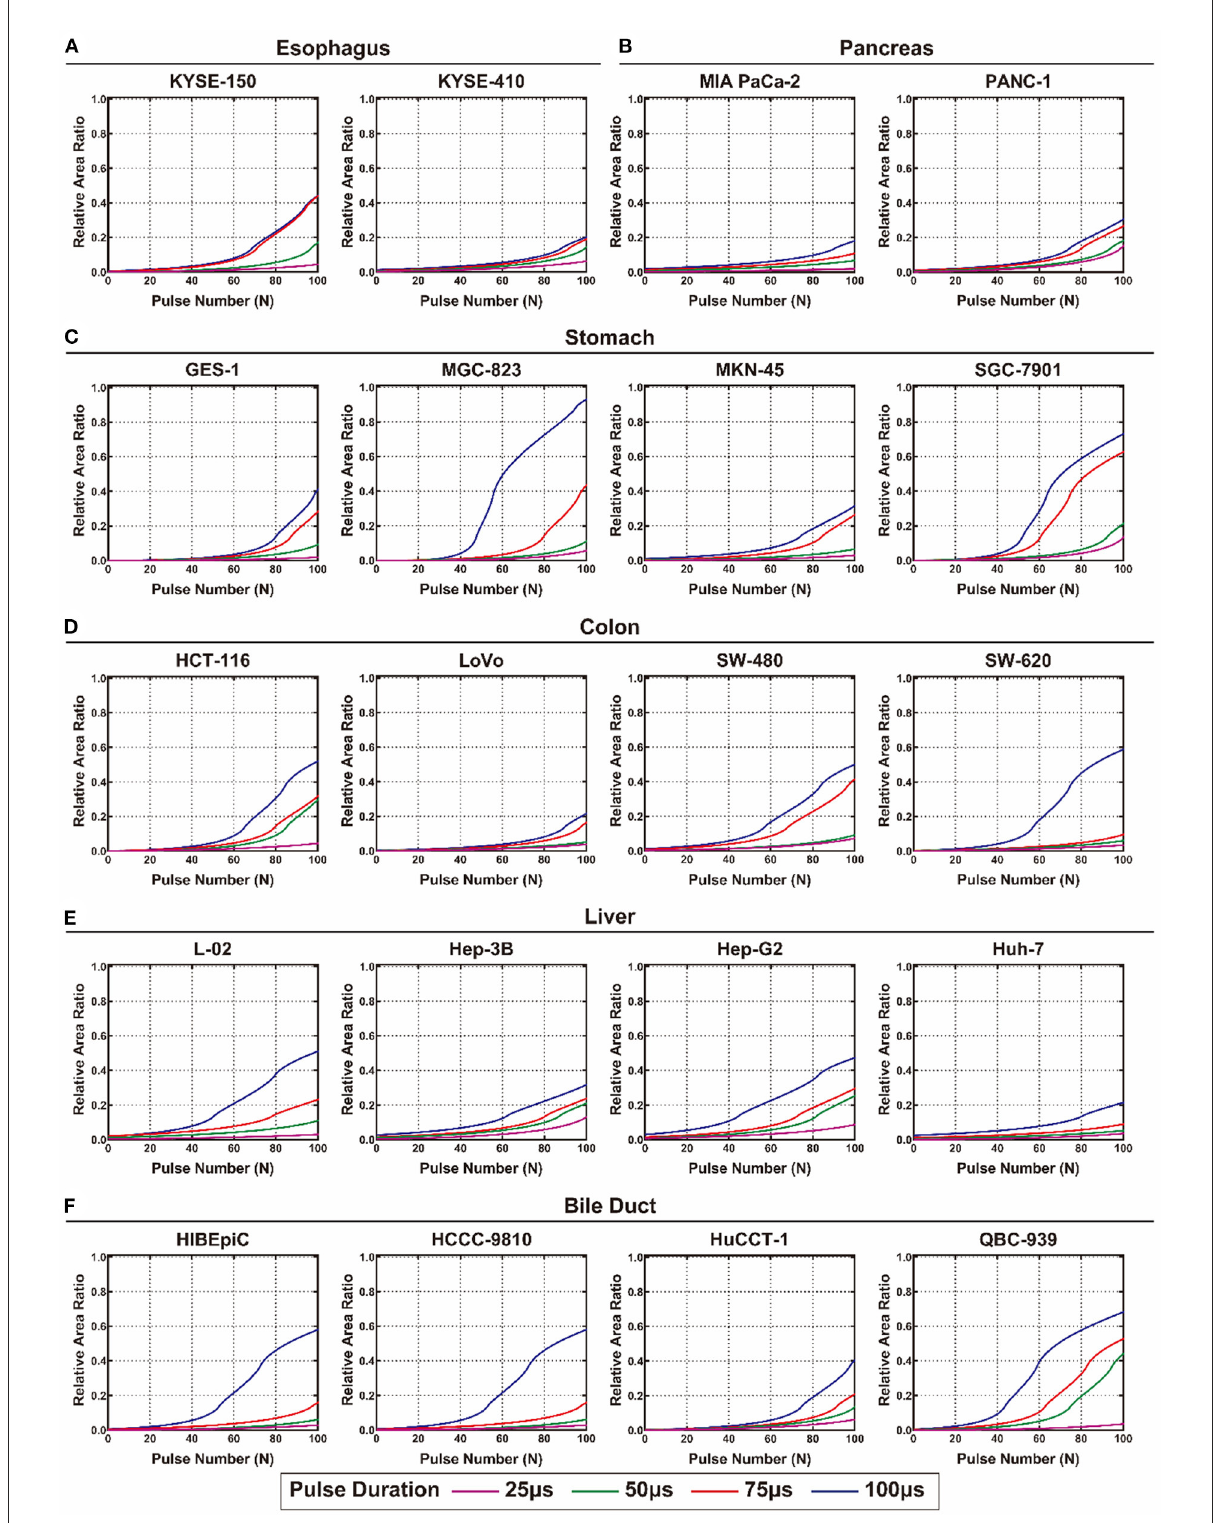
FIGURE4 The calculated relative area ratio of the electrical injury to the digestive system. (A) Esophagus, (B) pancreas, (C) stomach, (D) colon, (E) liver, and (F) bile